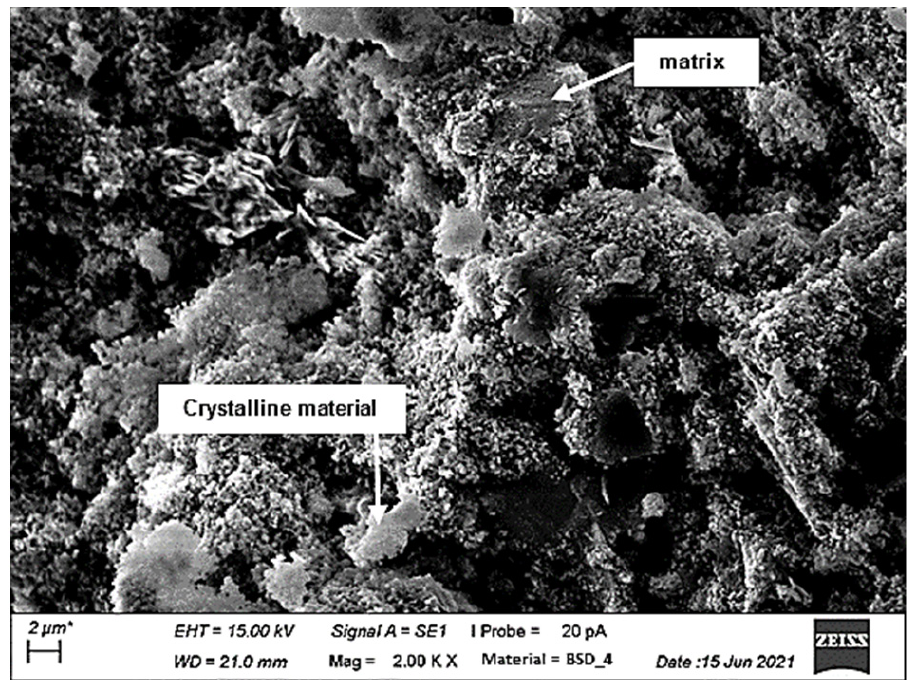
Figure 10. SEM image of the fracture surface of the brick sanding dust geopolymer at 2000 × magnification.